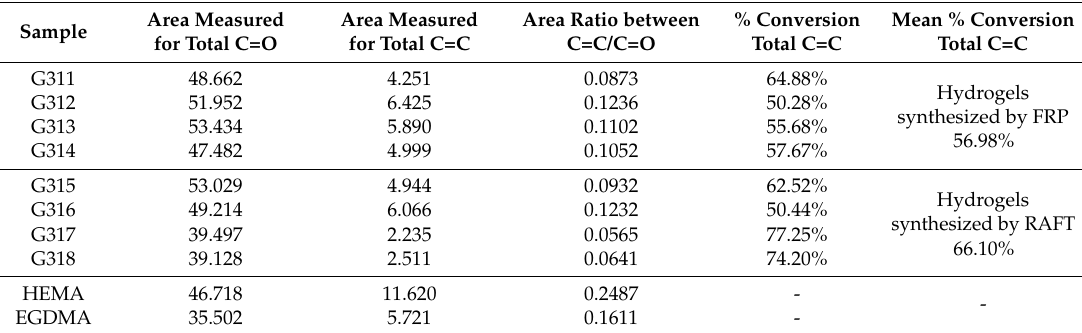
Table 5. FTIR quantifications results.